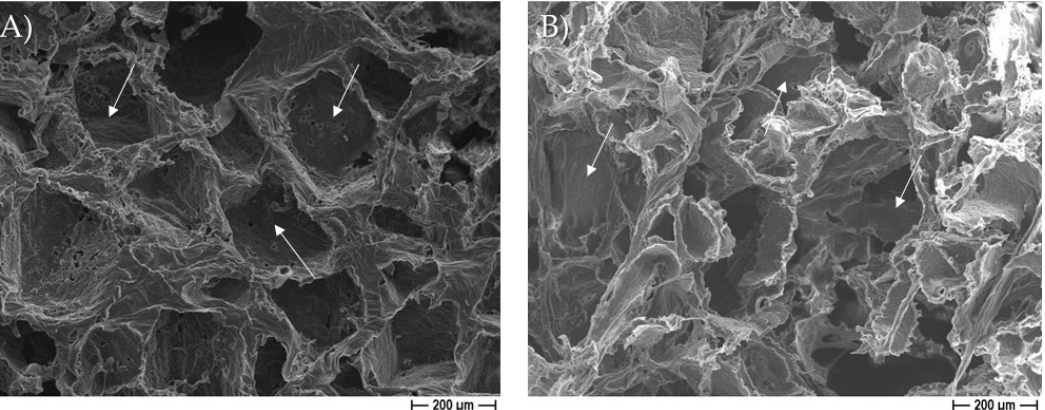
Figure 3. Representative higher magnification FESEM micrographs of PCL samples obtained by adding 30% eugenol EO to the polymer using NaCl ( A ) or 30% cinnamon oil to the polymer using NaNO 3 ( B ) as pore forming salt, showing microporosities within the struts, and on the pore walls (white arrows).